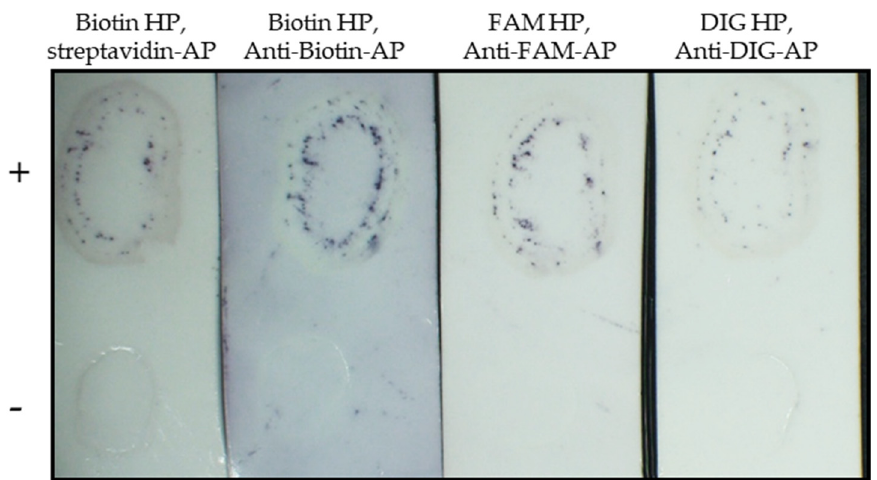
Figure 5. The tissue blot hybridization chain reaction (TB-HCR) with different reporter methods. TYLCV positive (+) and negative ( − ) blots were probed with TYLCV-P1, -P3, and -P4 and amplified and stained with: biotin HP, streptavidin-AP (used biotin hairpins, followed by incubation with streptavidin-AP, stained with BCIP/NBT): Biotin HP, anti-Biotin-AP (biotin hairpins, incubation with anti-biotin-AP, stained with BCIP/NBT): FAM HP, anti-FAM-AP (FAM hairpins, incubation with anti-fluorescein-AP, stained with BCIP/NBT): DIG HP, anti-DIG-AP (DIG hairpins, incubation with anti-digoxigenin-AP, stained with BCIP/NBT).